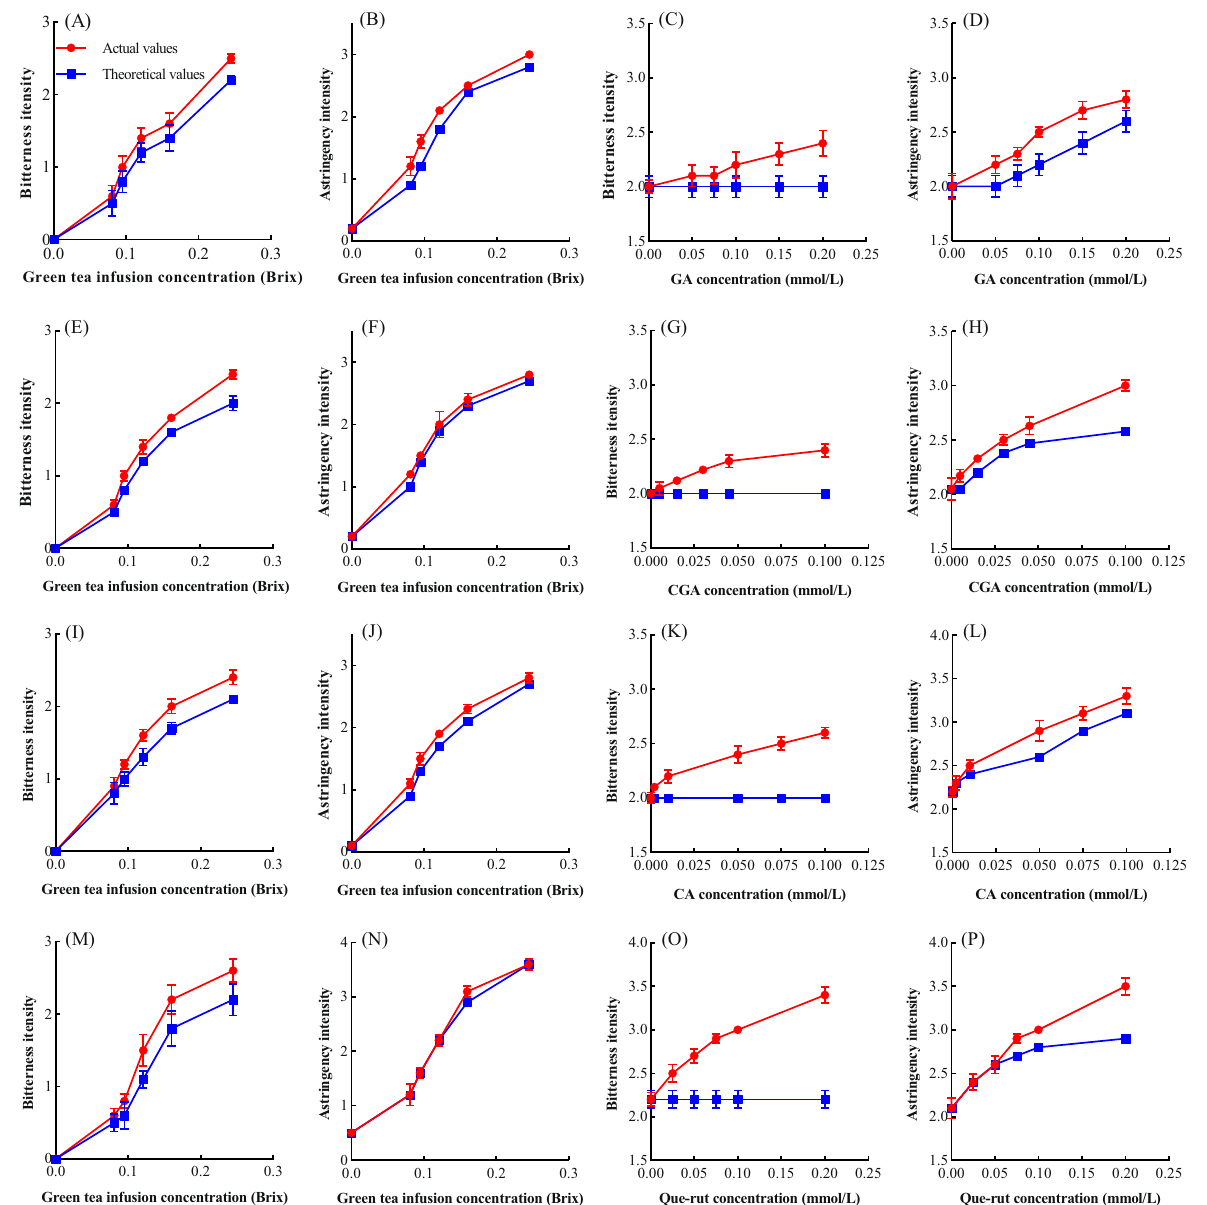
Fig. 3 Taste interactions between green tea infusion and typical phenolic acids and Que-rut. GA ( A , B ), CGA ( E , F ), CA ( I , J ), and Que-rut ( M , N ) show the bitter and astringent taste interactions at different concentrations of green tea infusion. GA ( C , D ), CGA ( G , H ), CA ( K , L ), Que- rut ( O , P ) show the bitter and astringent taste interactions with green tea infusion at different concentrations of GA, CGA, CA, and Que-rut. Actual values represent mixed system sensory scores between the different concentrations of green tea infusion and GA, CGA, CA, and Que- rut. Theoretical values represent the sum of the bitter and astringent taste points of each concentration of green tea infusion and the theoretical bitter and astringent taste of GA, CGA, CA, and